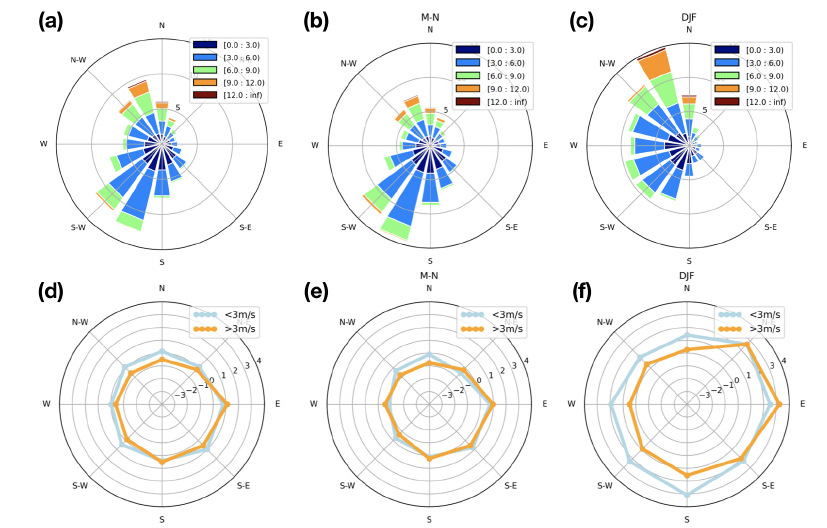
Figure 7. The wind rose plot of the regional mean wind speed and wind direction within 39.5–40.0 ◦ (latitude) and 116.0–117.0 ◦ (longitude) at 950 hPa derived from the ERA5 reanalysis data on all the FTIR measurement hours ( a ); in spring, summer, and autumn (March–November ( b )); and in winter (DJF ( c )). The medians of the ∆ XCO 2 at eight wind directions in all seasons ( d ); in spring, summer, and autumn (March–November ( e )); and in winter (DJF; ( f )). Here, we define weak wind and strong wind with a wind speed of <3 m/s and >3 m/s,